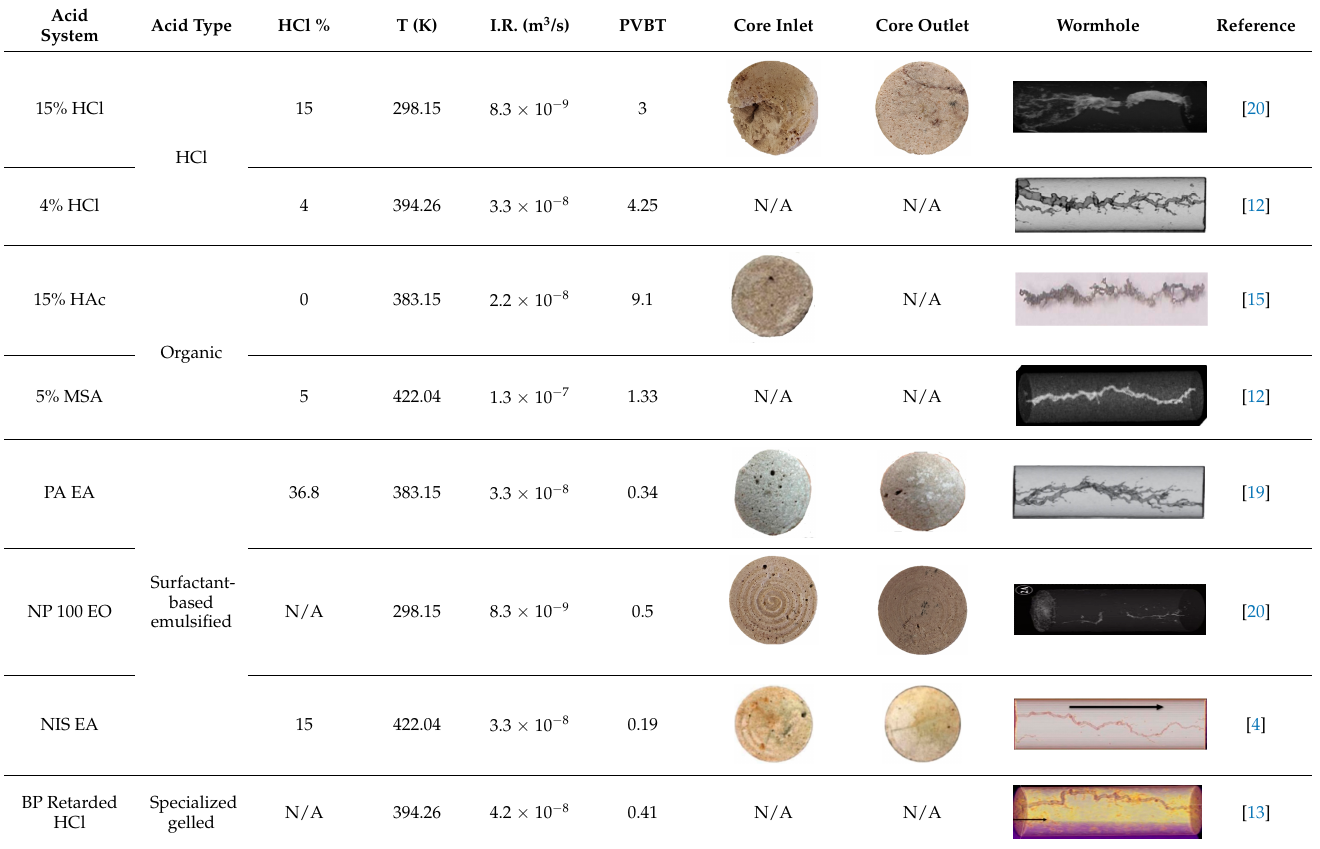
Table 1. Experimental characteristics and results from core flooding experiments from different acid systems at high temperatures.